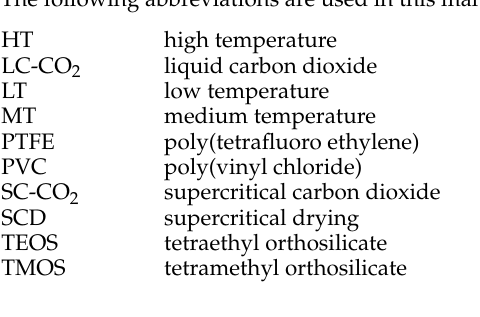
Figure S1: Visualization of important operation steps and valve settings of liquid carbon dioxide extraction and medium temperature (MT) supercritical drying of aerogels. Red circles: valve closed, green circles: valve open, Figure S2: Acid-base catalyzed aerogel sample holding 10 kg weight without cracking, Figure S3: Change of pressure (panel left) and pressure drop (panel right) as a function of time, calculated by the van der Waals equation for modeling a constant volumetric rate of 1.3 L/min (STP) decompression process of a 1.5 L dryer, which was filled with 1 L of liquid carbon dioxide at 291 K temperature and 5.4 MPa pressure, and heated to 353 K before decompression, Video S1: Evaporation of a dry ice sample containing acetone, Video S2: Evaporation of a dry ice sample free of